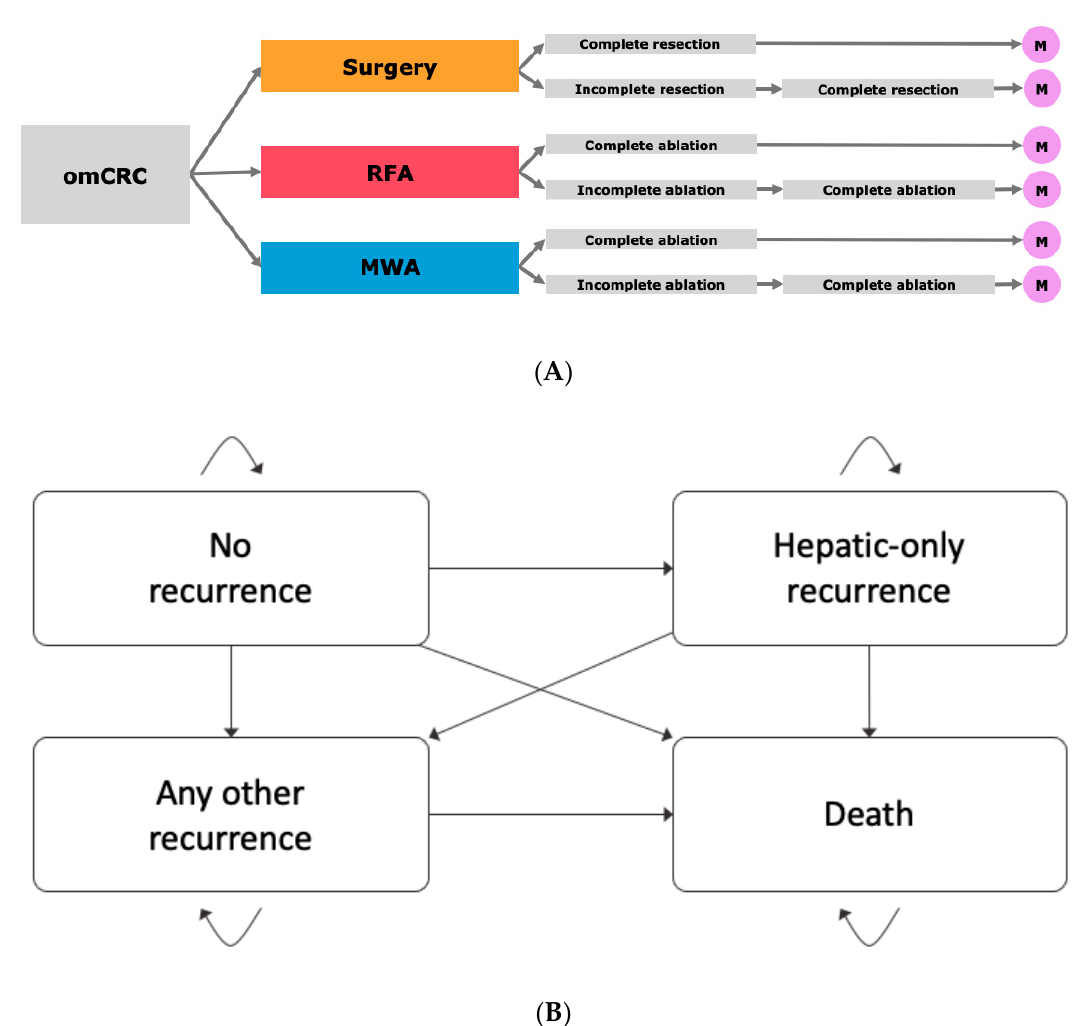
Figure 4. Model structure. ( A ) Overall model discriminating between the three treatment modalities surgery, microwave ablation (MWA) and radiofrequency ablation (RFA). ( B ) Markov Model for simulation of long-term outcomes containing the states “No recurrence”, “Hepatic-only recurrence”, “Any other recurrence” and “Death”.